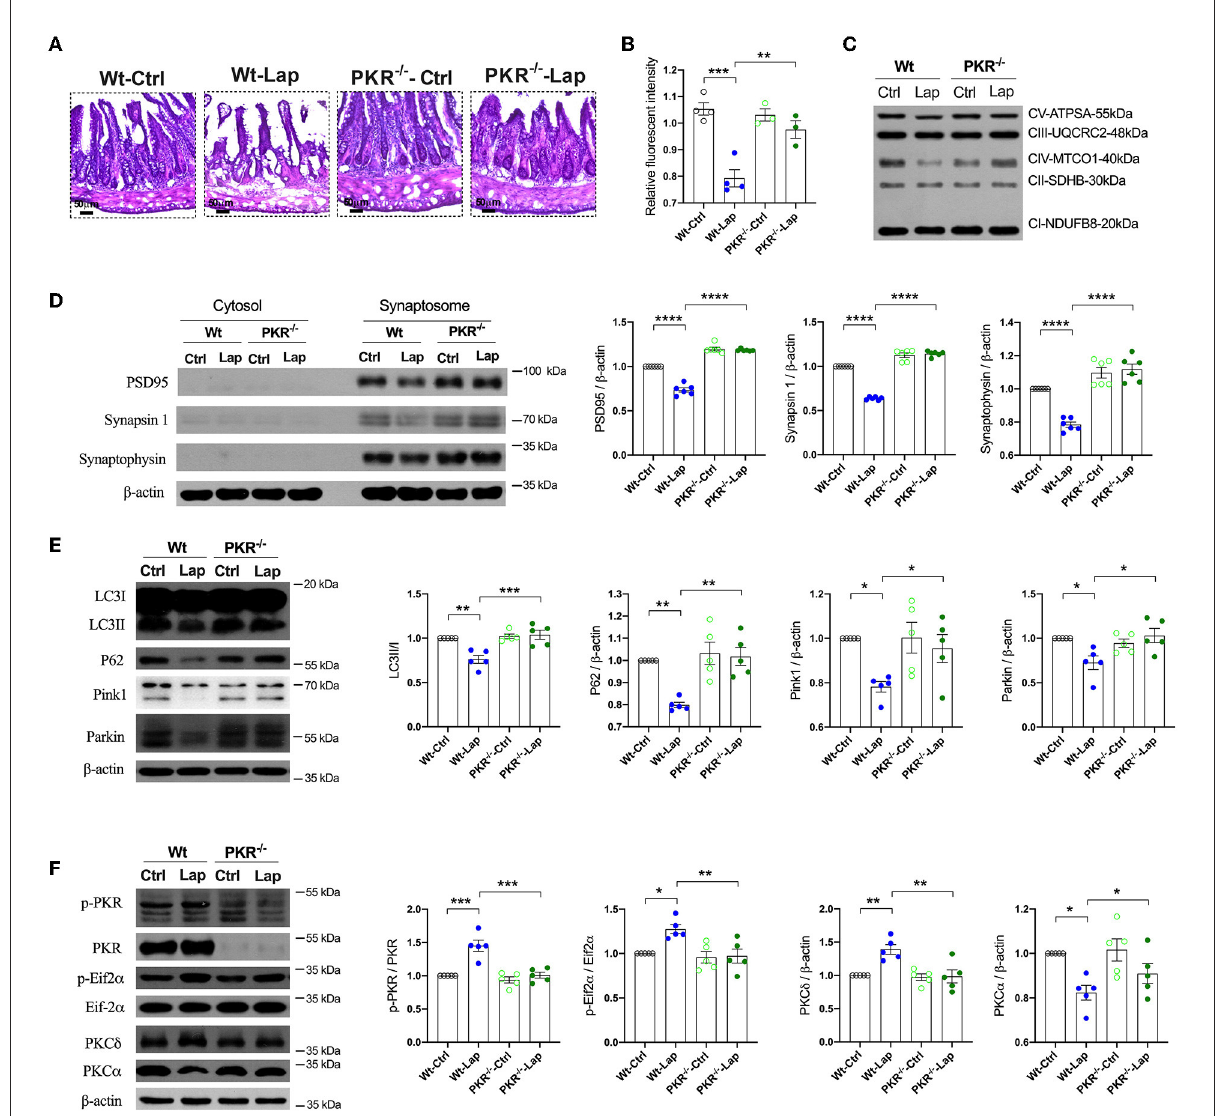
FIGURE7 Pathological signatures induced by laparotomy were determined by PKR activity. (A) Representative morphological changes of the intestine by H&E staining following laparotomy in the wild-type and PKR − / − mice. (B) Mitochondria membrane potentiation was detected by JC-1 assay in the isolated mitochondria fractions. F (3,10) = 18.96, P = 0.0002. (C) Representative Western blots of the mitochondria OXPHOS complex in the hippocampi after laparotomy in the wild-type and PKR − / − mice. (D) Western blots of synaptic proteins in the isolated synaptosome from postoperative hippocampi in the wild-type and PKR − / − mice. (E) Relative expressions of autophagy proteins, LC3B: F (3,16) = 12.58, P = 0.0002; P62: F (3,16) = 21.14, P < 0.0001; Pink1: F (3,16) = 17.26, P < 0.0001; Parkin: F (3,16) = 43.14, P < 0.0001. (F) Relative activities of PKC induced by laparotomy in the wild-type and PKR − / − mice. Wt, wild type; Ctrl, control; Lap, laparotomy. Data are presented as mean ± SEM and